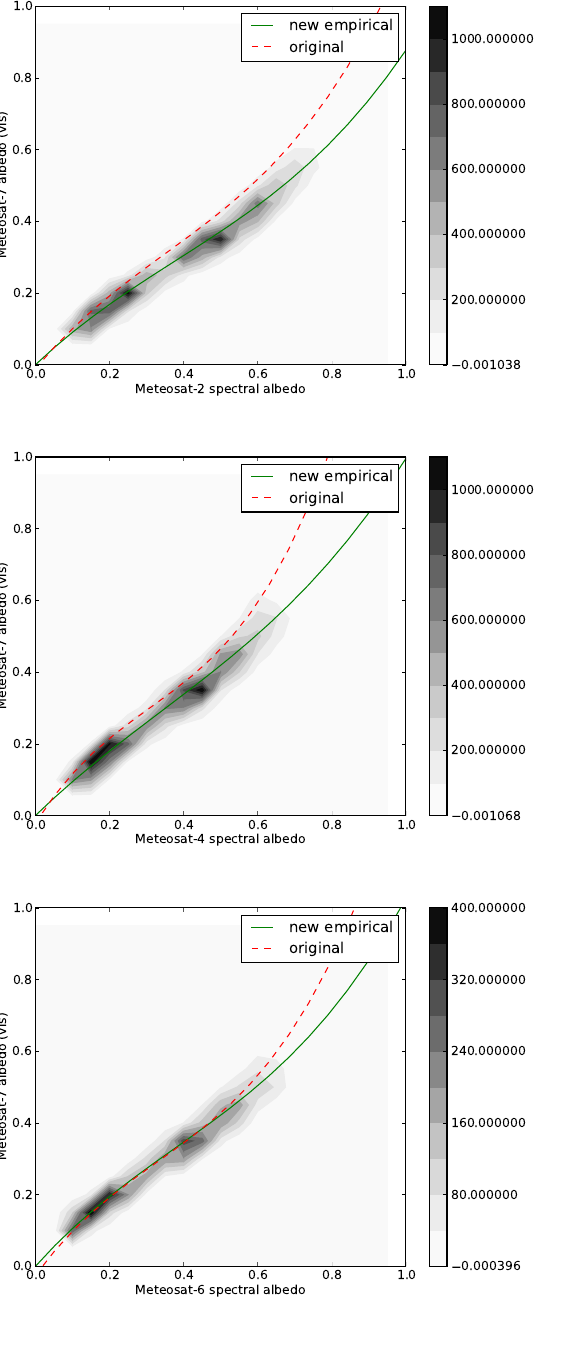
and BHR in the Meteosat iso,λ iso,bb